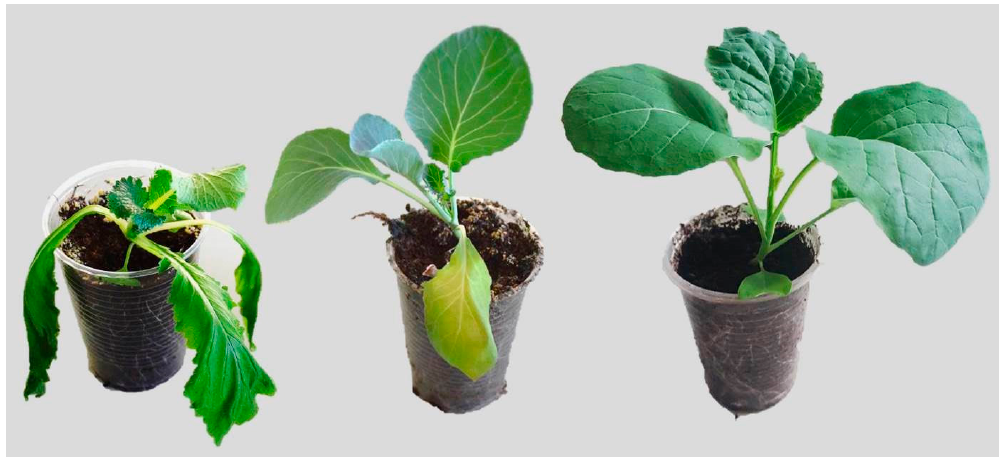
Figure 1. Brassica rapa ( left ), B. oleracea var. capitata ( middle ), and B . oleracea var. acephala ( right ) after 7 days of water deprivation.